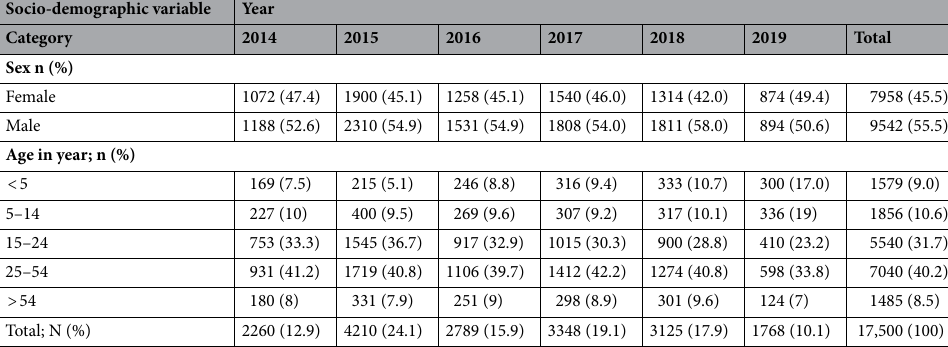
Table 1. Socio-demographic characteristics of patients request for malaria examination at University of Gondar Specialized Referral Hospital from 2014 to